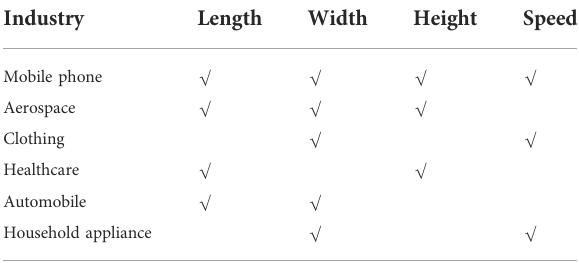
TABLE 4 Analysis of typical industry